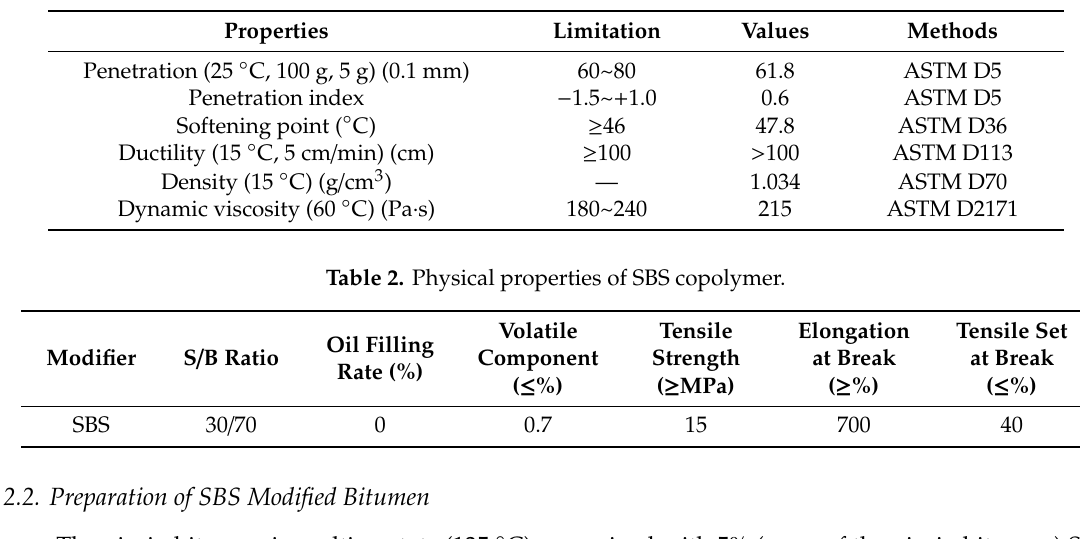
Table 1. Physical properties of 70# virgin bitumen.